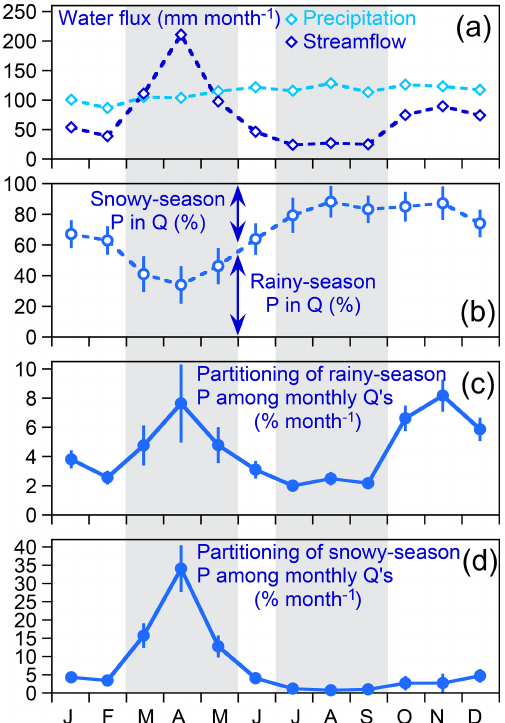
Figure 6. Patterns in monthly average precipitation and streamflow fluxes (a) , isotope hydrograph separations of rainy- and snowy- season precipitation in monthly streamflows (b) , and distributions of rainy-season (c) and snowy-season (d) precipitation in stream- flow (fraction of precipitation leaving as streamflow in each month). Proportions in (c) and (d) do not sum to 100% because they do not include evapotranspiration losses (which are 18% and 44% of snowy-season and rainy-season precipitation, respectively). Aver- age precipitation fluxes vary little from month to month, whereas average streamflow fluxes show clear high flows resulting from snowmelt from March through May and clear low flows attributable to evapotranspiration losses from July through September (a) . Both intervals are marked by gray shading. Monthly isotope hydrograph separations (b) show larger fractions of snowy-season precipitation in streamflow during the snowmelt period, followed by a steadily growing fraction of rainy-season precipitation that reaches a peak of nearly 90% in August. However, much more rainy-season precipi- tation becomes streamflow during snowmelt (c) , when its fractional contribution to streamflow is lowest (b) , than during late summer, when its fractional contribution to streamflow is relatively high (b, c) . This occurs because monthly total streamflow is much higher during snowmelt than during the high-ET conditions of late sum- mer. A relatively large proportion of rainy-season precipitation also becomes streamflow in October through December, as monthly total streamflow recovers after the end of the summer ET peak. The pro- portion of snowy-season precipitation becoming streamflow (d) un- surprisingly peaks in during peak snowmelt, when monthly stream- flow is highest and the fractional contribution of snowy-season pre- cipitation to that streamflow is likewise